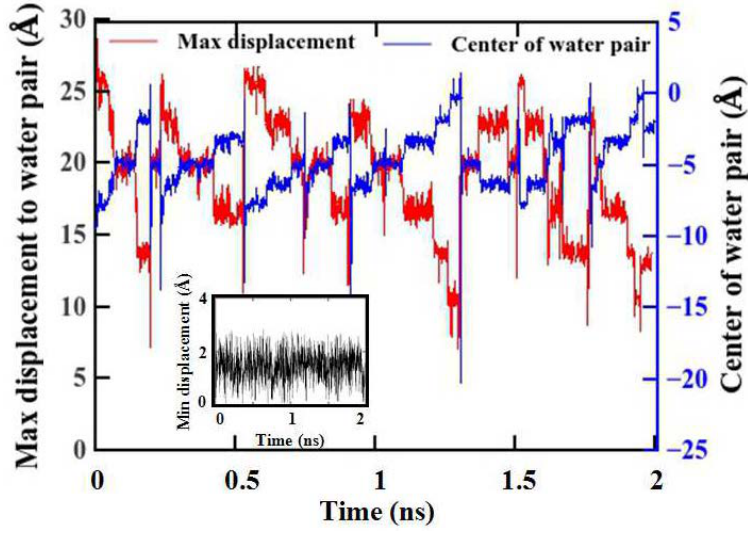
Figure 3. Difference between the location of adjacent water molecules along the axial direction of the pore and the center z position of the maximum difference.